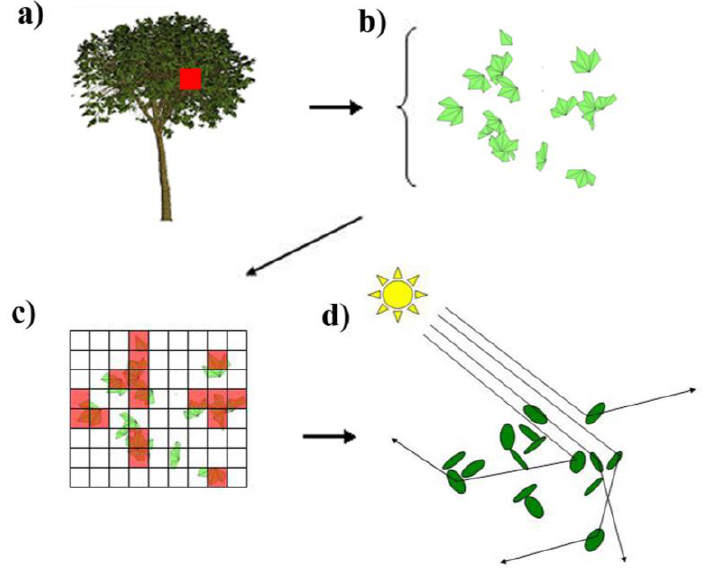
Figure 1. Schematic overview of the Voxel-based Light Interception Model (VLIM): The forest stand consisted of several trees (a), the leaf distribution of the canopy (b) was represented by a collection of voxels based on the acquired LiDAR data (c), and each of the filled leaf voxels was abstracted by a disc for ray tracing purposes